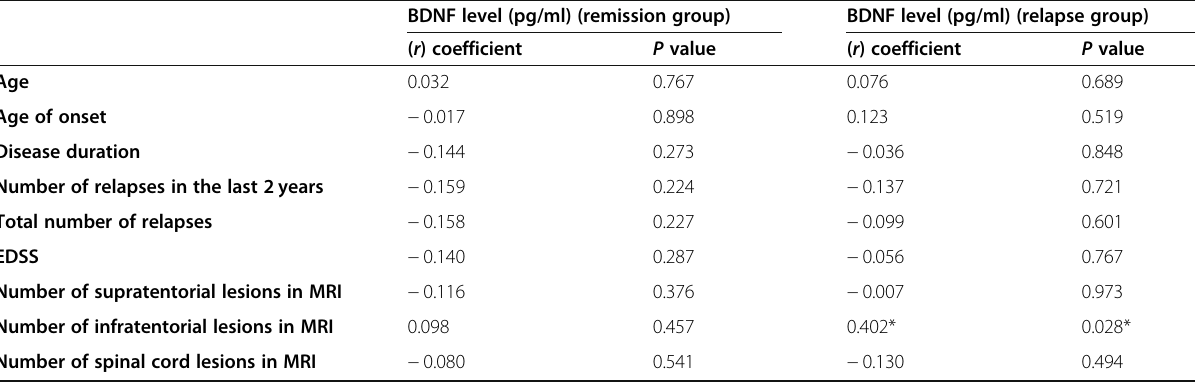
Table 4 Correlation between different characteristics of MS patients and BDNF level BDNF level (pg/ml) (remission group) BDNF level (pg/ml) (relapse group) ( r ) coefficient P value ( r ) coefficient P